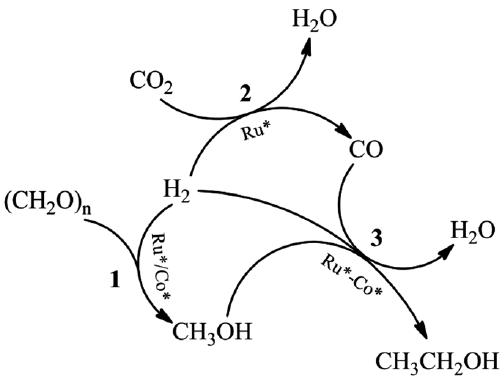
Figure 15. Synergy between the processes used to fabricate ethanol from paraformaldehyde, CO 2 , and H 2 . The active species of Ru and Co are represented, respectively, by Ru* and Co*. Reprinted with permission from Ref. [150]. Copyright © 2017, Royal Society of